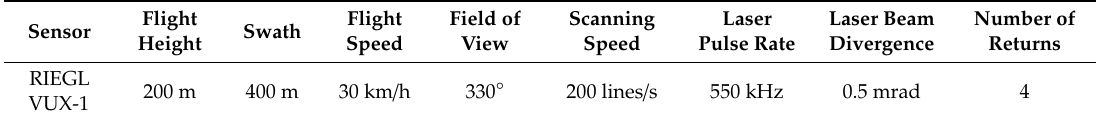
Table 1. Details about data